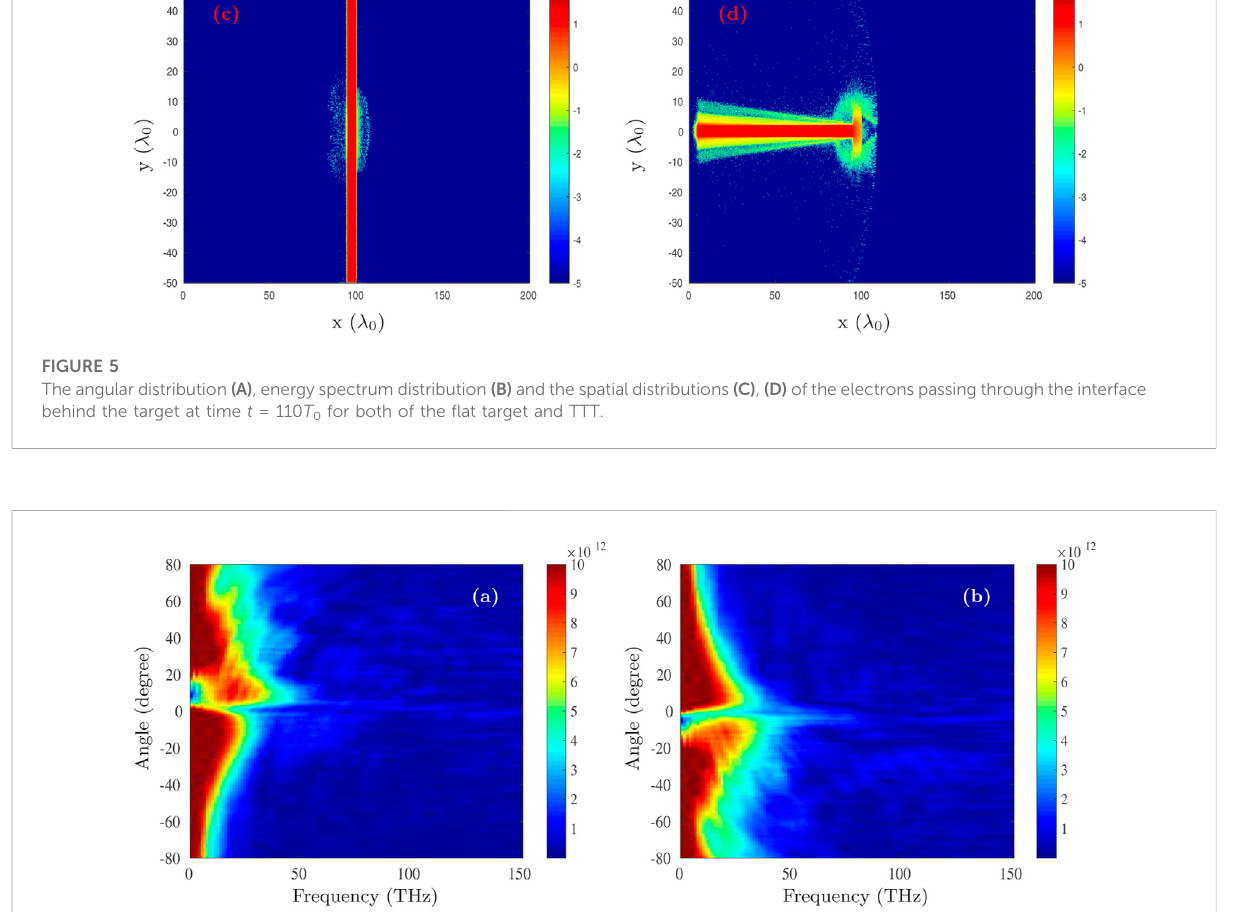
avoid the interference of the quasi-static fi elds formed behind the target and the noise caused by the expansion of the target [30, 36]. First, Figure 2 shows the collected electromagnetic fi eld over time for both of the fl at target and TTT. We can observe from